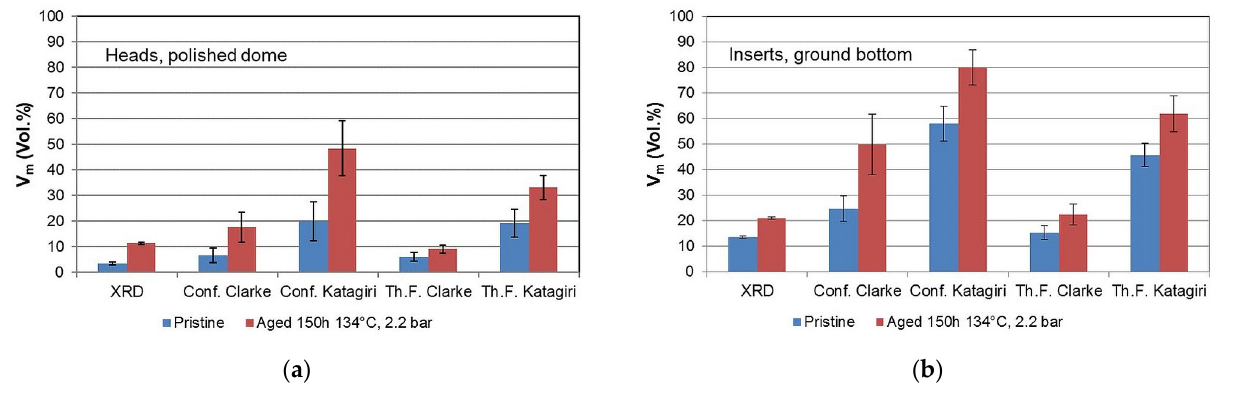
Figure 2. Values of V m measured by Raman spectroscopy and XRD on both non-aged and in vitro aged Delta heads ( a ) and inserts ( b ). Conf. = confocal pinhole closed down to 100 µm (penetration depth of Raman signal: 4.2 µm); Th. F. = confocal pinhole fully open (1000 µm)—penetration depth of Raman signal: 15 µm.